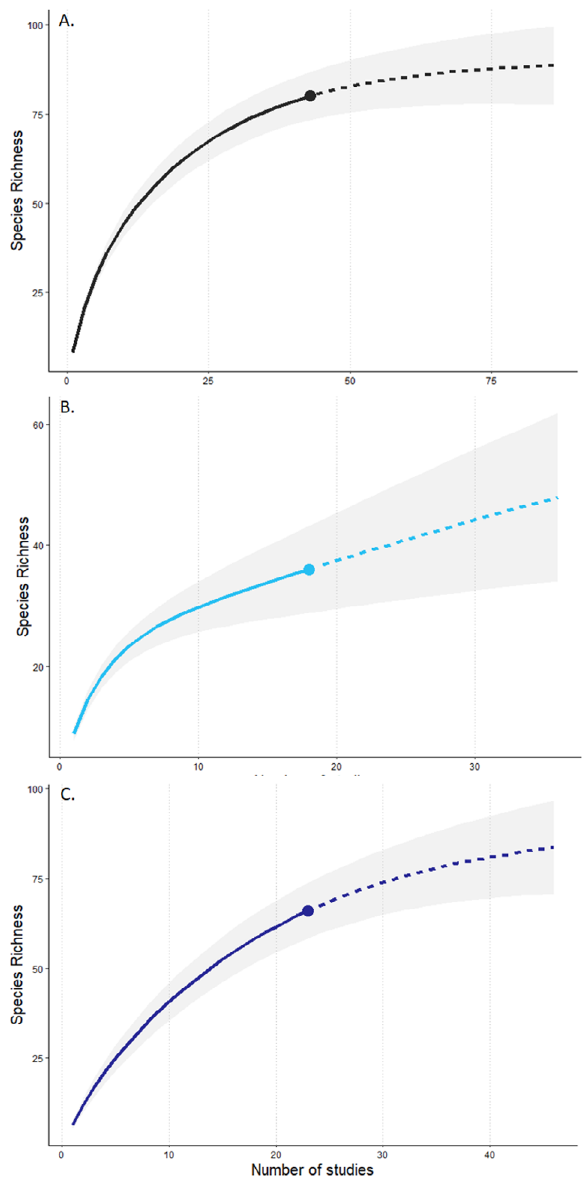
Figure 2. Observed richness (OS, full line) and extrapolated richness (ES, dashed line) using the Hill number (q = 0 species richness) of the Cladoceran fauna observed, considering the number of studies, in Rio de Janeiro State (A; OS=80, ES=90), Paraiba do Sul (B; OS=36, ES=51) and Fluminense (C; OS=66, ES=91). Confidence interval of 95 % was obtained by the bootstrap method and represented by the shaded area of the fitted